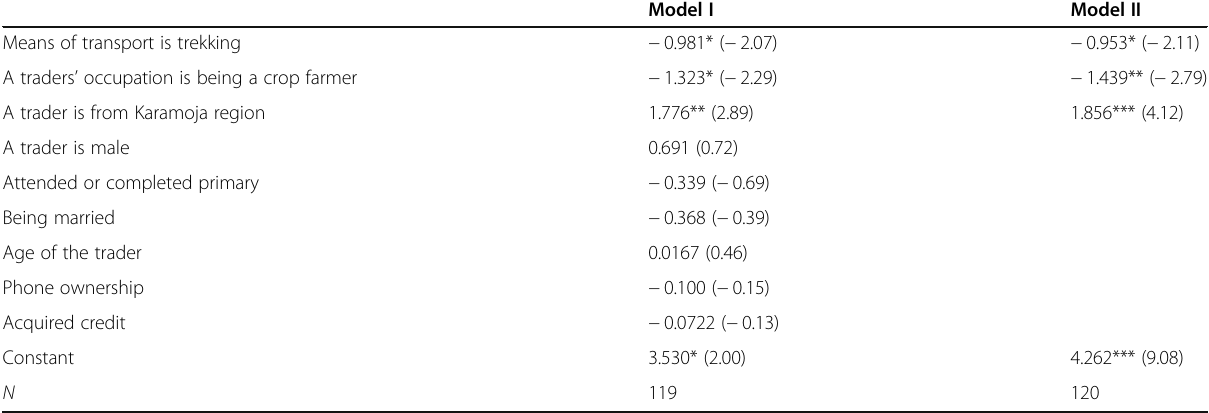
Table 5 Correlates of the magnitude of the decline in the number of cattle sold per trader per month